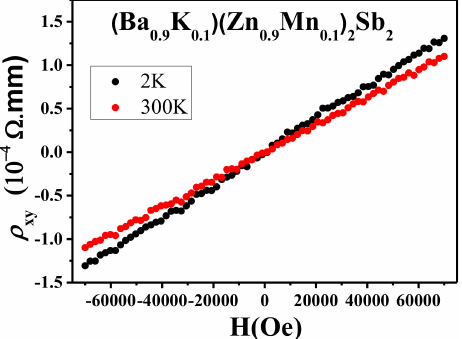
Figure 6. Hall resistivity of (Ba 0.9 K 0.1 )(Zn 0.9 Mn 0.1 ) 2 Sb 2 at T = 2 and 300